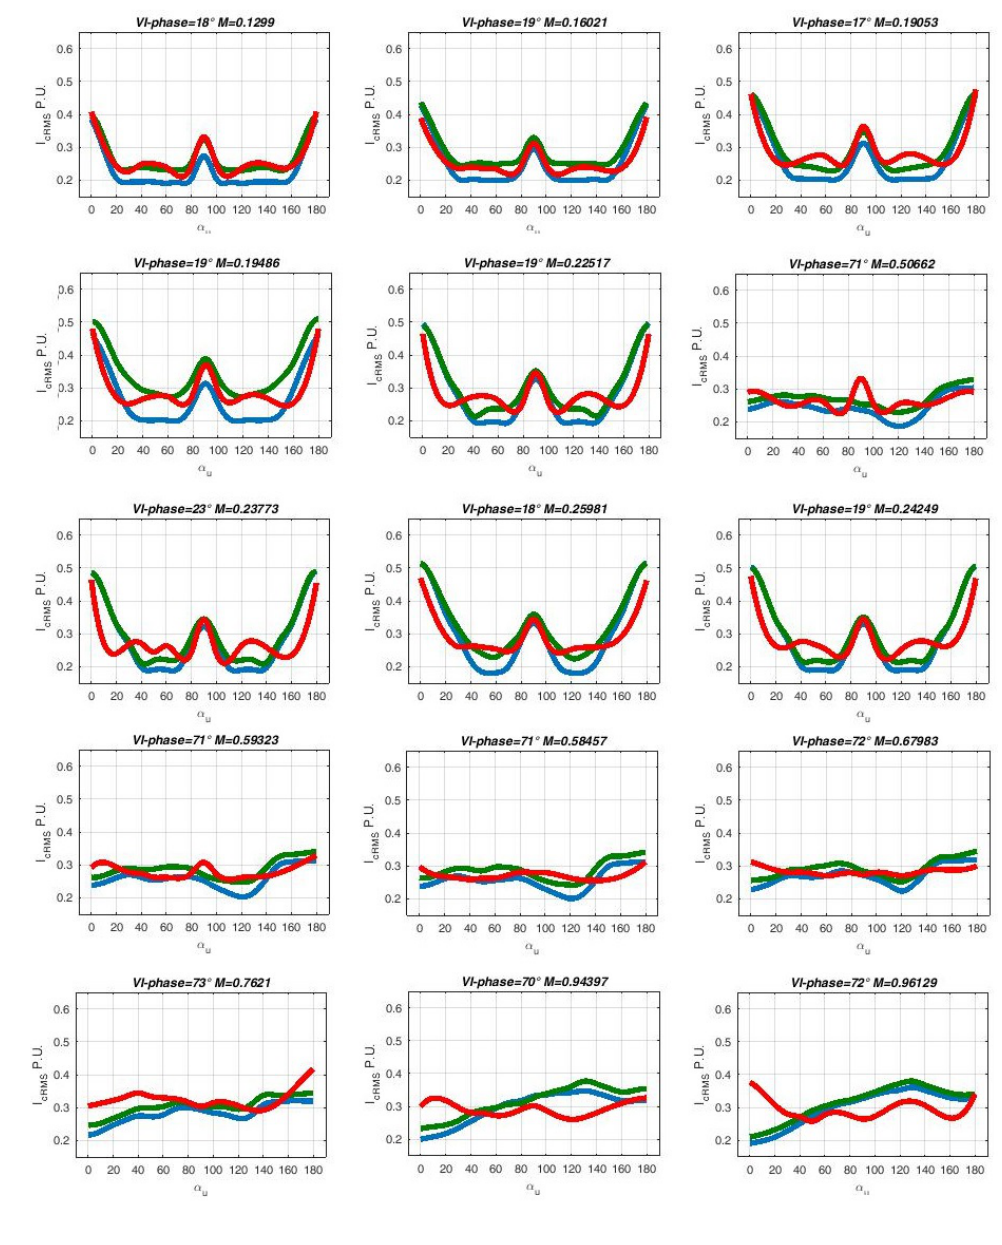
Figure 18. Each picture shows I C values for different α u and different couples of M and VI-phase. rms The blue line is the simulated I C for triple-3-phase converter in Figure 4, the green line is the rms simulated I C considering a model of the triple-3-phase converter used in the laboratory setup with rms estimated concentrated resonance parameters, and the red line is the measured evolution of I C the laboratory